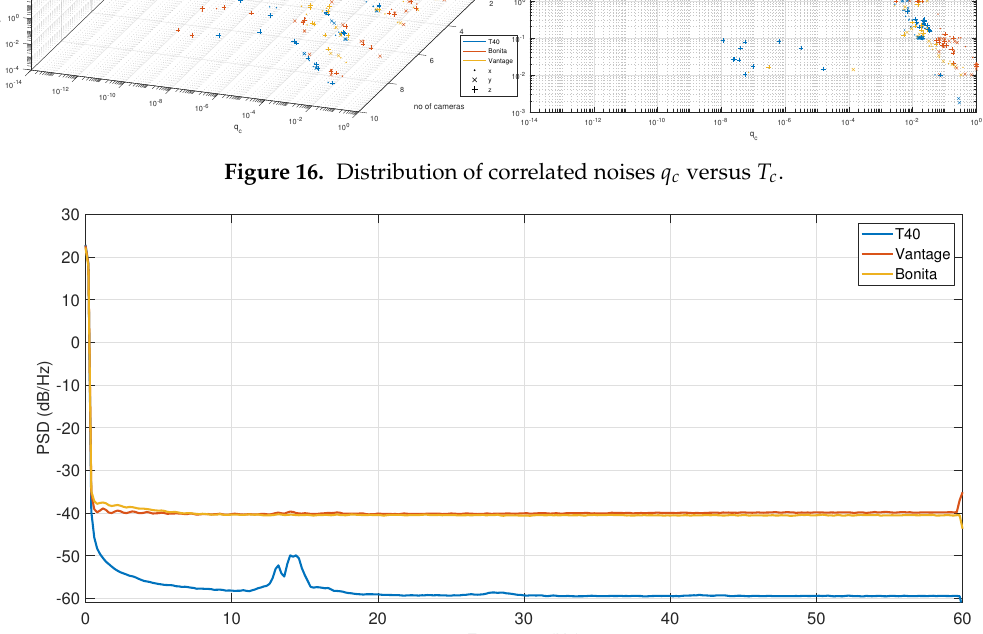
Figure 17. Exemplary verification of periodic distortion using PSD for z 1 reconstructed with maximal number of devices for each camera